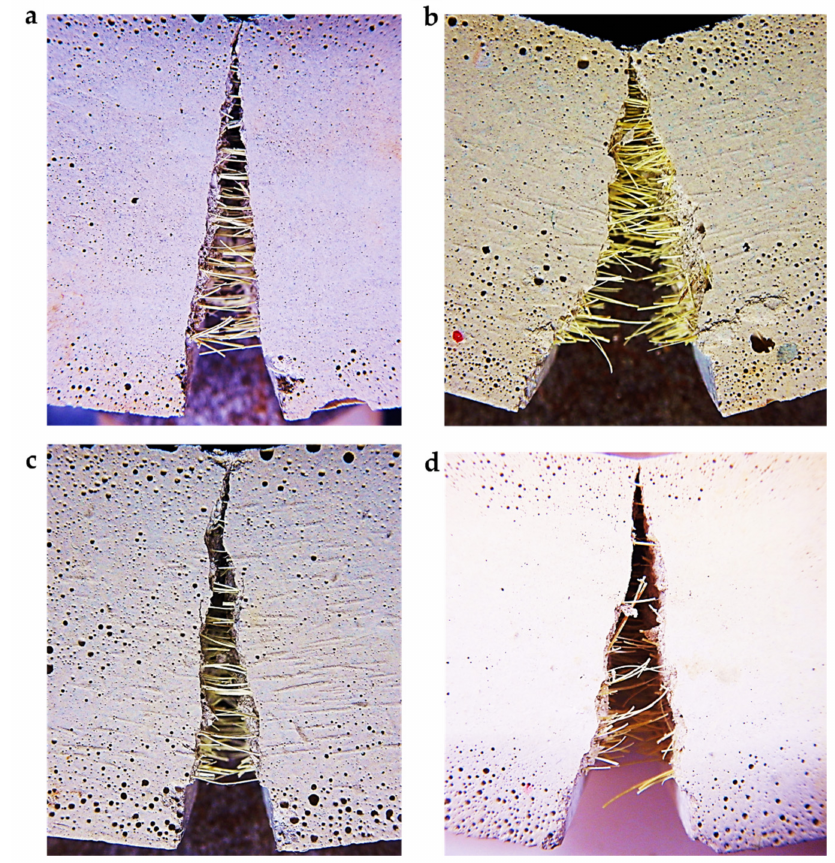
Figure 21. Cracks after the 3PBTs. ( a ) Fibers F2, 0.6%; ( b ) Fibers F2, 1.0%; ( c ) Fibers F1, 0.6%; ( d ) Fibers F1,